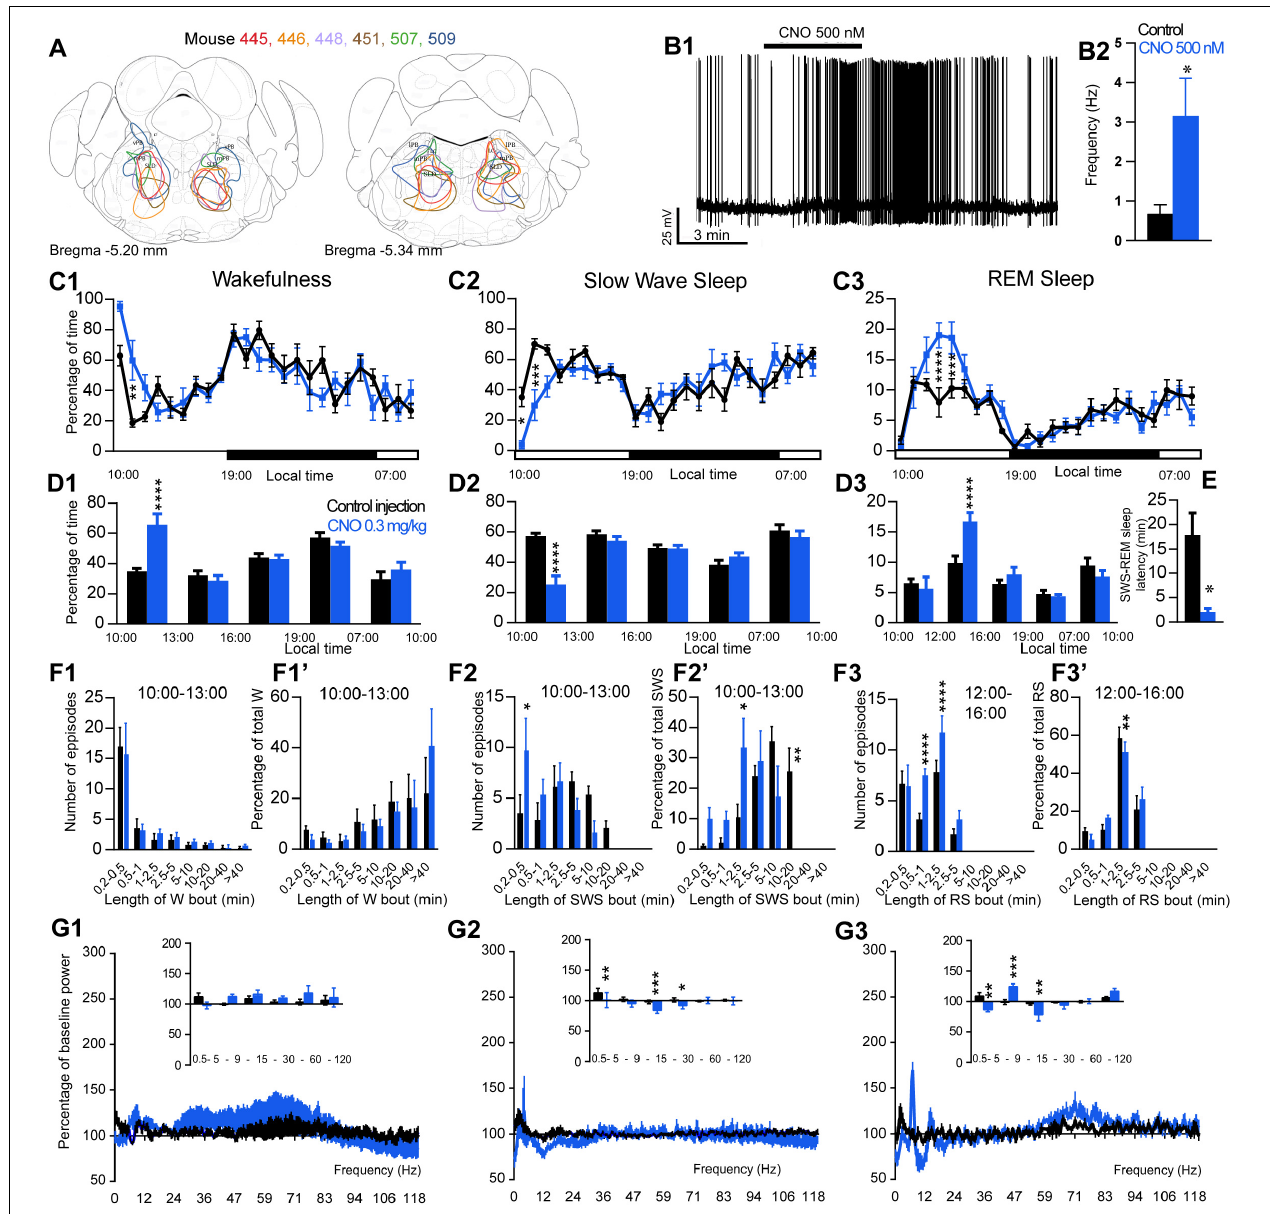
FIGURE 3 | Activation of SLD glutamatergic neurons during the inactive period (10:00 or ZT3). (A) Extent of transduced neurons (mCherry-positive somas) is shown for individual Vglut2-IRES-cre mice that received bilateral injections of hM3Dq-mCherry-AAV into the SLD (SLD Vglut2 − hM3Dq ). (B1) SLD Vglut2 − hM3Dq whole-cell recording showing an increase in firing frequency in response to bath application of CNO (0.5 µ M). (B2) Average firing frequency ( ± S.E.M.) during the last 2 min of the CNO (0.5 µ M) application as compared with the 2 min period preceding CNO application (control; N = 6 PB rmVglut 2 − hM 3 Dq neurons). ∗ p < 0.05 Paired Student’s t -tests. (C) Hourly amount of wakefulness (C1) , SWS (C2) and REM sleep (C3) following CNO (0.3 mg/kg, N = 6 mice) as compared with control injection. (D1,D2) Percentage of wakefulness and SWS ( ± S.E.M.), respectively, during the 3 h post-injection period (10:00–13:00), the following 3 h (13:00–16:00), the remainder (3 h) of the light/sleep period (16:00–19:00), the subsequent 12 h dark period (19:00–07:00) and first 3 h of the light period of the next day (07:00–10:00, N = 6 mice). (D3) Percentage of REM sleep ( ± S.E.M.) during the 2 h post-injection period (10:00–12:00), the following 4 h (12:00–16:00), the remainder (3 h) of the light/sleep period (16:00–19:00), the subsequent 12 h dark period (19:00–07:00) and first 3 h of the light period of the next day (07:00–10:00, N = 6 mice). (E) SWS to REM sleep latency defined as the time (min) between the onset of the first SWS episode ( > 20 s) and the onset of the first REM sleep episode ( > 10 s). (F1–F3) Number of episodes ( ± S.E.M.) of wakefulness (W), SWS or REM sleep (RS) in each bout length and (F1’–F3’) time-weighted frequency histograms showing the proportion ( ± S.E.M.) of W, SWS or RS amounts in each bout length as a percentage of the total amount of W, SWS during the 3 h post-injection period (10:00–13:00) or RS during the 12:00–16:00 period ( N = 6). (G1–G3) Sleep-wake power spectrum changes over baseline during the 3 h (10:00–13:00) post CNO (0.3 mg/kg, N = 6 mice) injection as compared with control injection; and the quantitative changes ( ± S.E.M.) in power for the δ (0.4–5 Hz), θ (5–9 Hz), α (9–15 Hz), β (15–30 Hz), low γ (30–60 Hz) and high γ (60–120 Hz) frequency bands ( ± S.E.M.) following vehicle or CNO (0.3 mg/kg, N = 6 mice) administrations. (C–G) Control injection in Black, CNO injection in blue; ∗ p < 0.05, ∗∗ p < 0.01, ∗∗∗ p < 0.001, ∗∗∗∗ p < 0.0001, two-way ANOVA followed by a post hoc Bonferroni